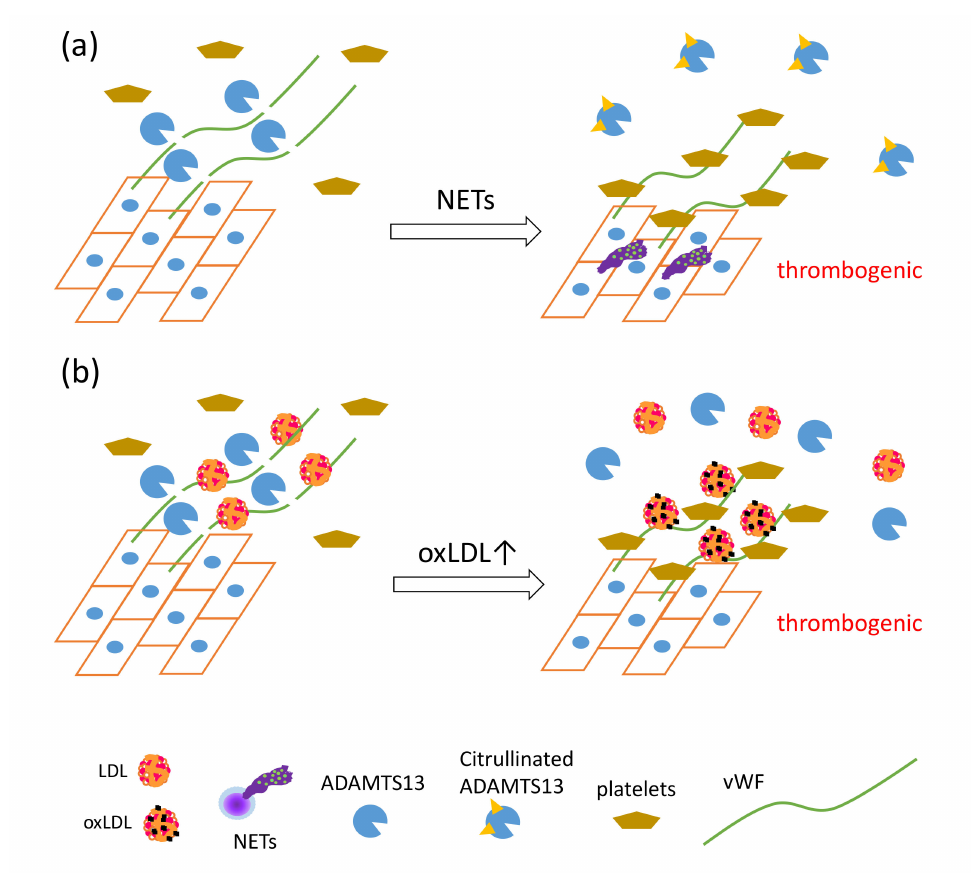
Figure 4. The synergistic actions of NET formation and oxLDL production presumably cause a proatherothrombotic status on the vascular endothelium. ( a ) PAD4 secreted by NET formation mediates citrullination of ADAMTS13, which inhibits the proteolytic activity of ADAMTS13 against von Willebrand factor (vWF), leading to increased vWF-platelet string formation on the endothelium [41]. ( b ) LDL, identified as a novel vWF-binding partner, accelerates the proteolytic cleavage of ultra-large vWF by ADAMTS13 under shear stress, and inhibits adhesion of platelets to ultra-large vWF. OxLDL, having lower ability to enhance proteolytic activity of ADAMTS13 than native LDL, competes with native LDL, which in turn increases platelet adhesion to ultra-large vWF, which could cause thrombus formation rich in vWF, platelets, and DNA